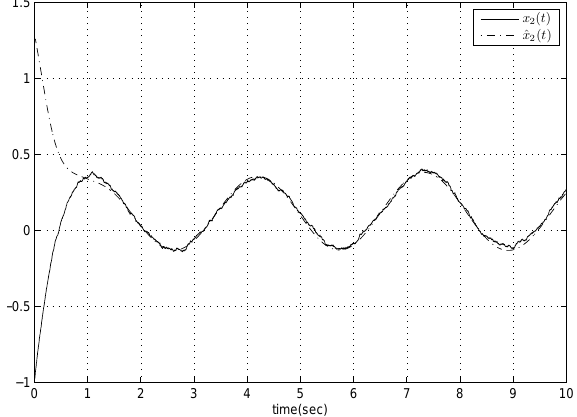
Fig. 3. Responses of the state x 2 ( t ) and its estimation b x 2 ( t )